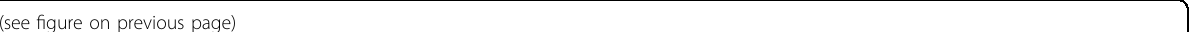
Fig. 5 SDF4 interacts with CXCR4 receptor to induce VEGFD expression for angiogenesis by phosphorylating ERK and p38 pathway proteins in endothelial cells. A Cell membrane fractions were incubated with or without GST-SDF4, and then, a co-immunoprecipitation assay was performed with antibody against SDF4, GST or CXCR4. B An immuno fl uorescence assay was conducted to assess GST, SDF4, and CXCR4 signals. C Angiogenesis was assessed by counting the branched intersection number of SDF4-treated HUVECs with or without AMD3100 treatment as indicated. D , E The activity of AKT1, ERK1/2, and p38 in response to SDF4 (0.5 μ g/ml) and with or without AMD3100 (20 μ g/ml) treatment in the indicated time courses. F Angiogenesis was assessed by counting the branched intersection number of HUVECs treated with SDF4 and/or the indicated kinase inhibitors or SDF4 combined with pretreatment with increasing concentrations of wortmannin, PD98059 or SB203580. G VEGFD expression in response to various signaling inhibitors on SDF4-treated HUVECs. Three independent experiments were performed in triplicate. H LLC1- Luc2 cells were orthotopically inoculated into the lung of C57BL/6 mice. The experimental mice were treated with CDDP or AMD3100 as indication after inoculation with tumor cells. Representative in vivo bioluminescent images and total tumor fl ux of LLC1-Luc2-bearing mice in each group shown at 5th week. n = 8 per group. All data are expressed as the mean ± S.D. Differences among groups were analyzed with the one-way ANOVA followed by Tukey ’ s multiple comparison test. * p < 0.05, ** p < 0.01, *** p <